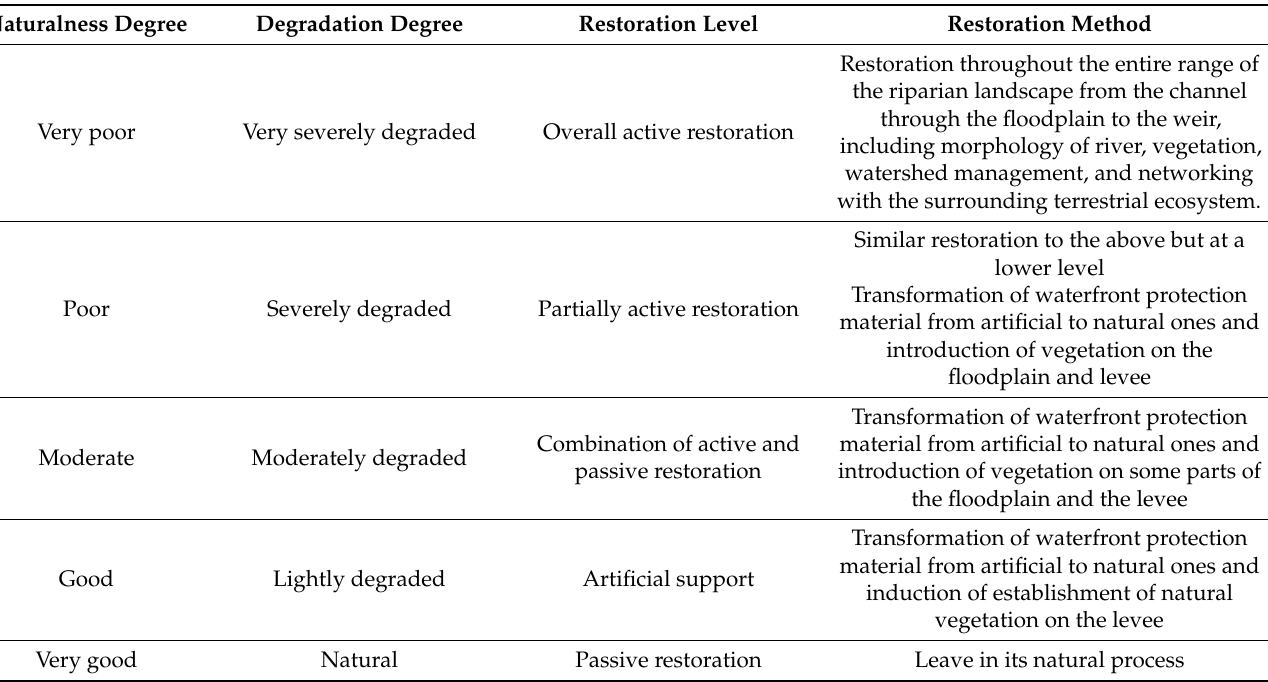
Table 6. Level and method of restoration recommended based on a diagnostic evaluation of the rivers throughout the whole national territory of South